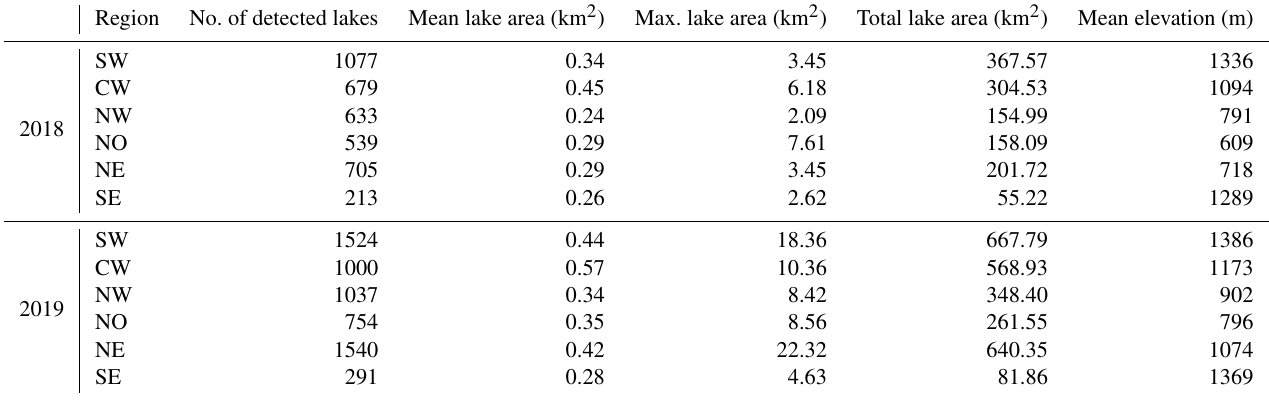
Table B2. Detected surface lake statistics.